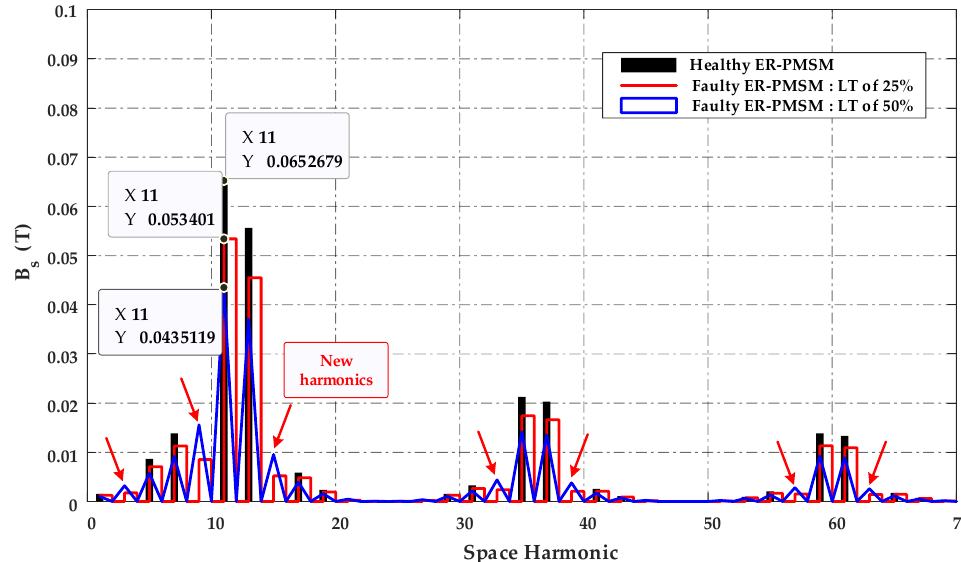
Figure 10. Spatial harmonic spectrum of the healthy and faulty air-gap flux density.